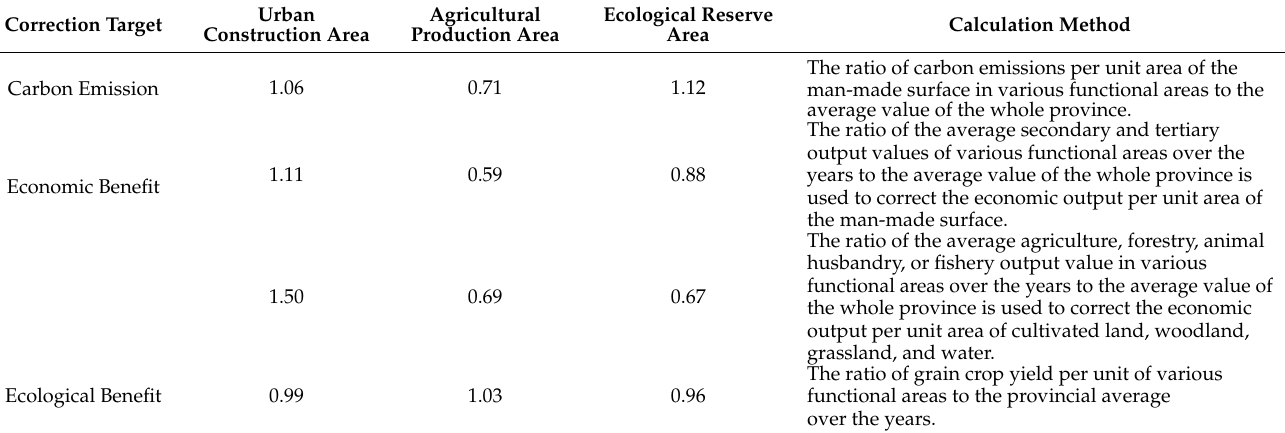
Table 4. Correction coefficient and calculation method of each main functional